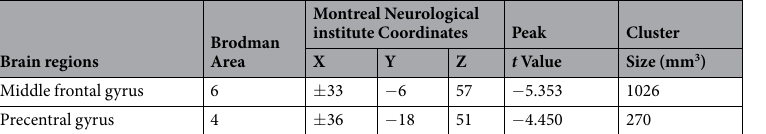
The middle frontal gyrus is within the prefrontal lobe and plays an important role in the prefrontal-limbic system. The prefrontal lobe is generally considered to be the advanced cognitive center which participates in integrat- ing emotion and information about internal and external environment, and extracting episodic memory in the resting-state 36 . Two rs-fMRI studies 36, 37 revealed abnormal regional homogeneity in the middle frontal gyrus in BD in the depressive episode. Several researches using task-based fMRI, such as the modified word-based mem- ory task, working memory, response inhibition, and emotional face encoding, indicated decreased or absent 38–42 activity of the middle frontal gyrus and limbic system in BD patients and increased activity in pediatric BD after pharmacotherapy during a response inhibition task fMRI 43 . Several structural MRI 44–47 also showed the smaller